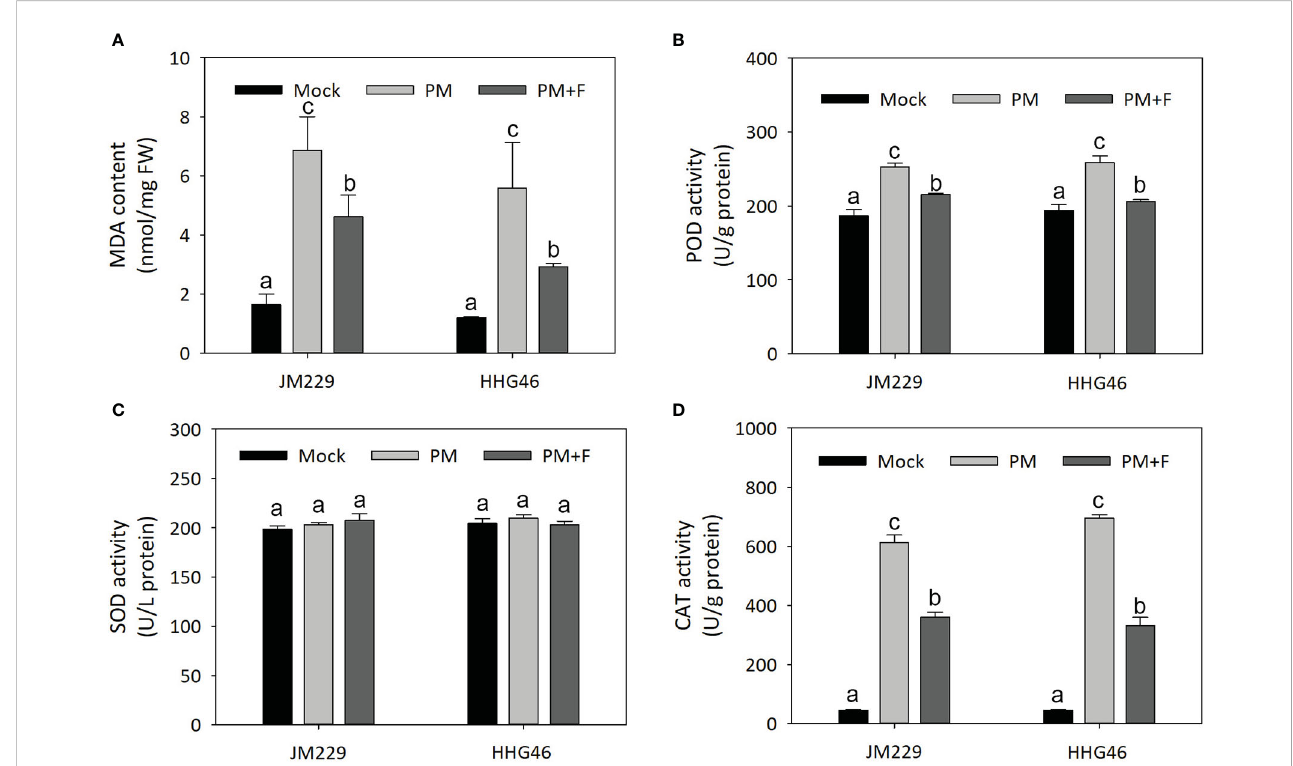
FIGURE 7 Defense-related responses against powdery mildew with or without fl avonoids treatment in wheat leaves. (A) MDA content. Activity of (B) POD, (C) SOD, and (D) CAT in cv. Jimai229 and cv. HHG46 under mock, PM, and PM+F treatment conditions. Error bars represent mean standard deviation of triplicate experiments. Different letters represent signi fi cant differences at the 5% probability level. CAT, catalase; MDA, malondialdehyde; PM, inoculated with powdery mildew; PM+F, inoculated with powdery mildew and treated with 100 m M fl avonoids solution; POD, peroxidase; SOD, superoxide